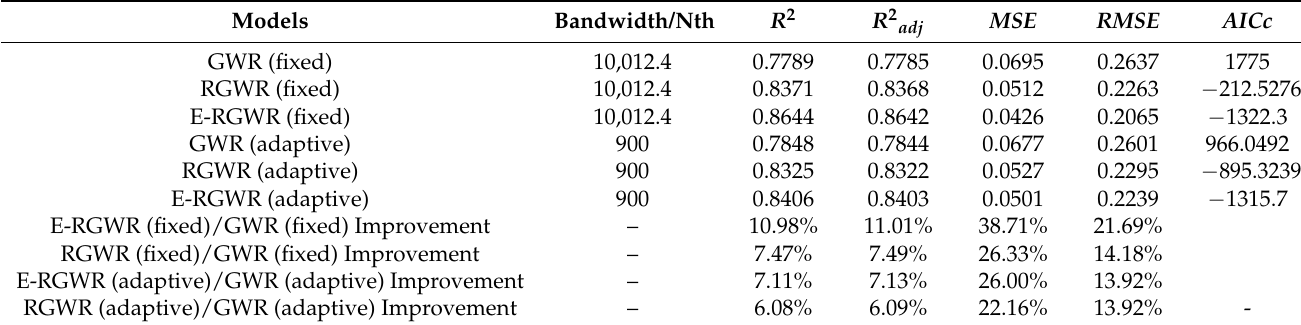
Table 3. The values of the E-RGWR, RGWR and GWR